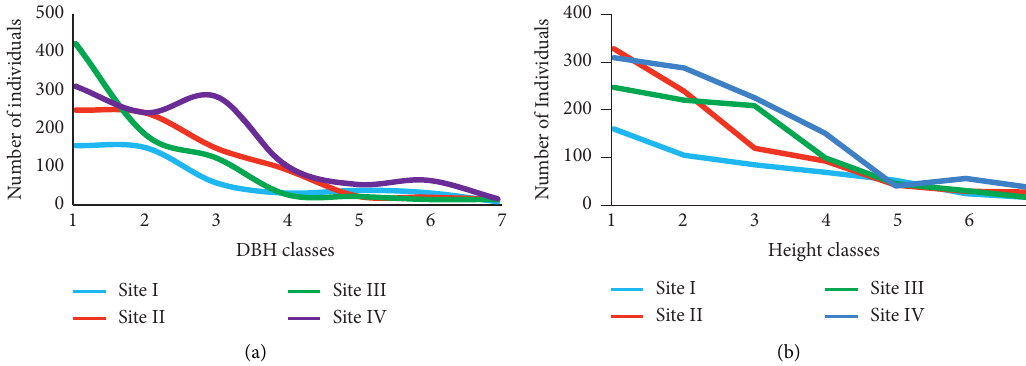
Figure 8: DBH and height class distribution of all individuals. (a) DBH classes: 1 � 5–10cm; 2 � 10.01–20cm; 3 � 20.01–30 cm; 4 � > 30.0140cm; 5 � 40.01–50 cm; 6 � 50.01–80cm; 7 � > 80cm. (b) Height classes: 1 � 2–5m; 2 � 5.01–10m; 3 � 10.01–15m; 4 � 15.01–20 m;